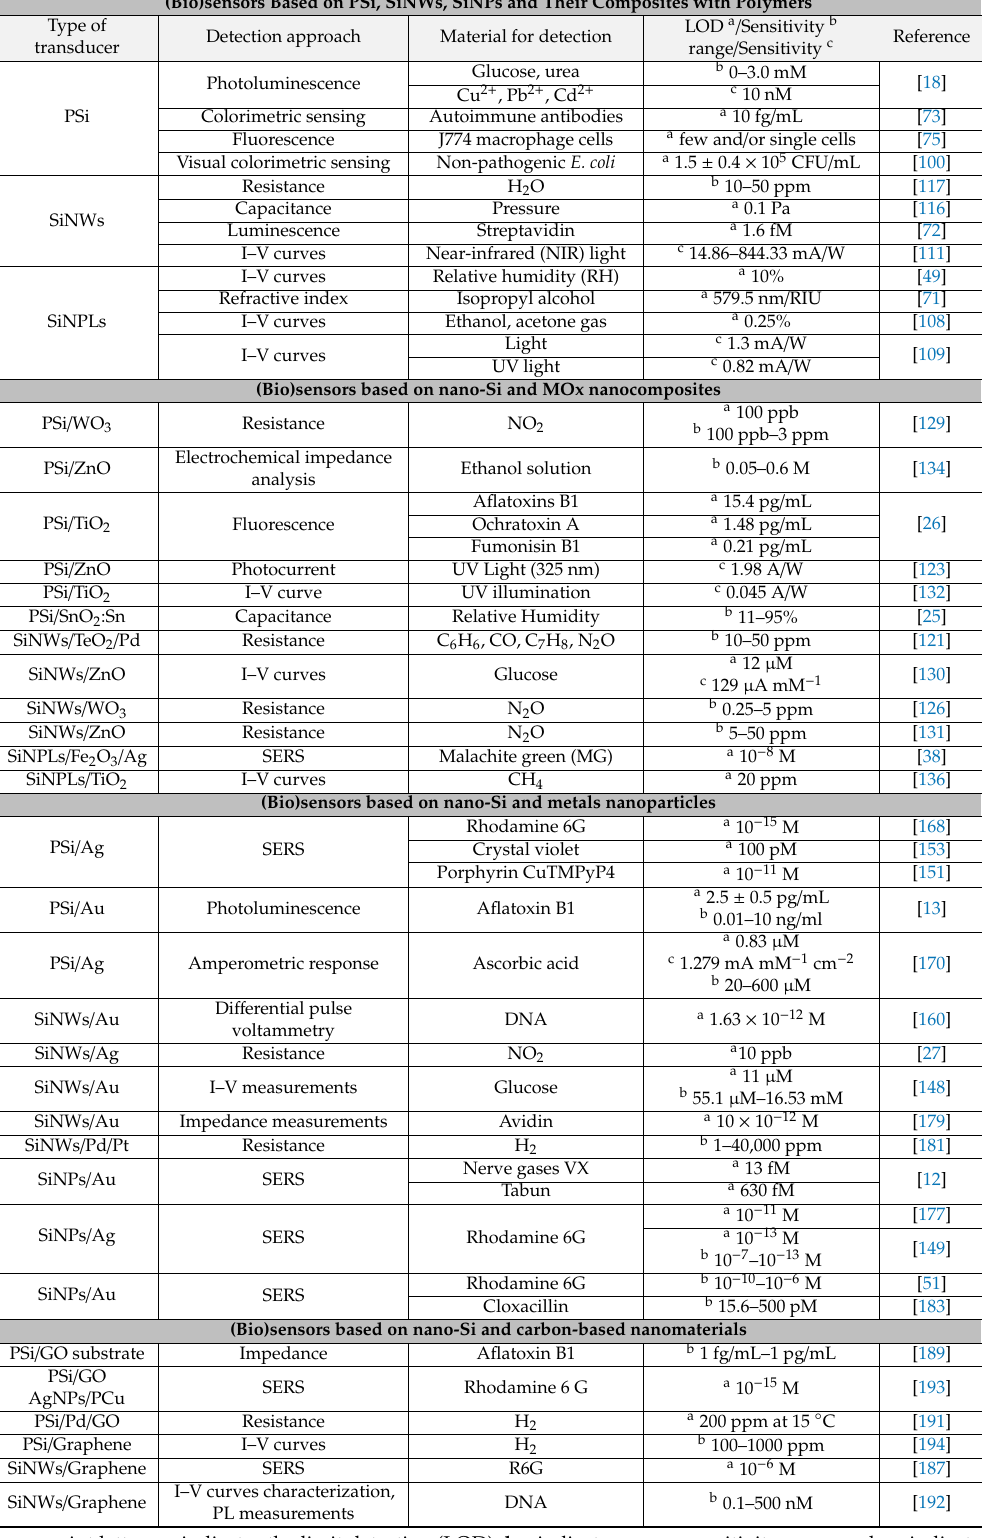
Table 1. Summarized data about nano-Si and nano-Si composites suitable for (bio)sensing applications. (Bio)sensors Based on PSi, SiNWs, SiNPs and Their Composites with Polymers Type of